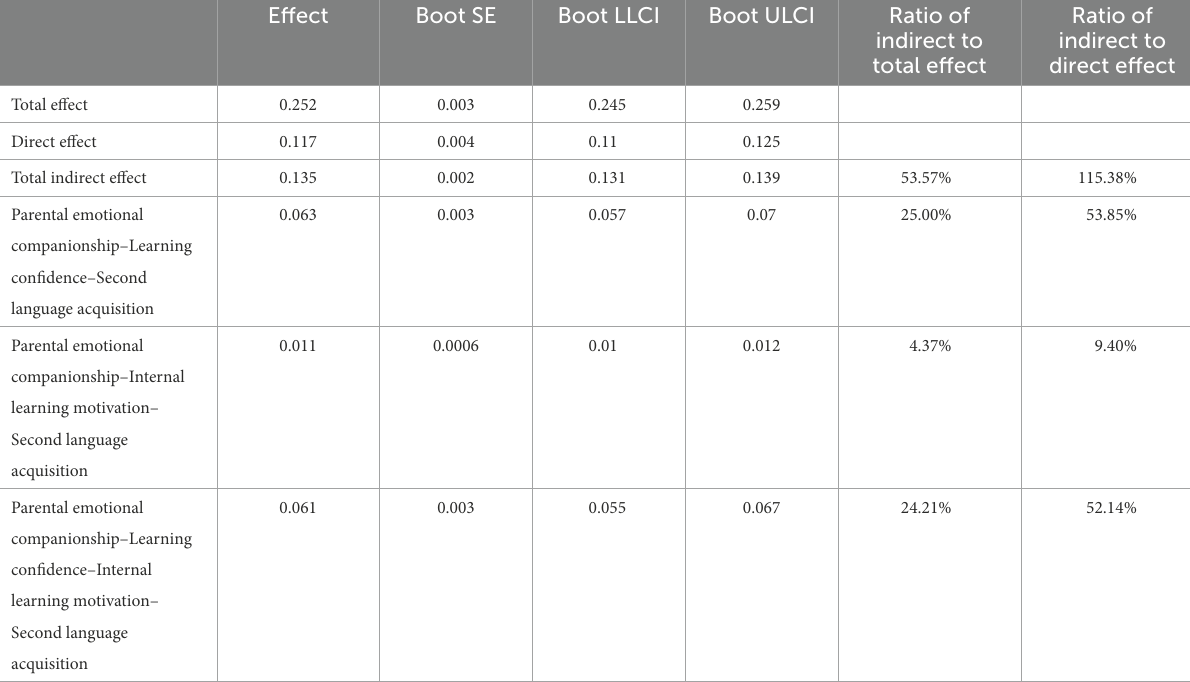
TABLE 5 Results of Bootstrap test of mediating effect in primary school group.